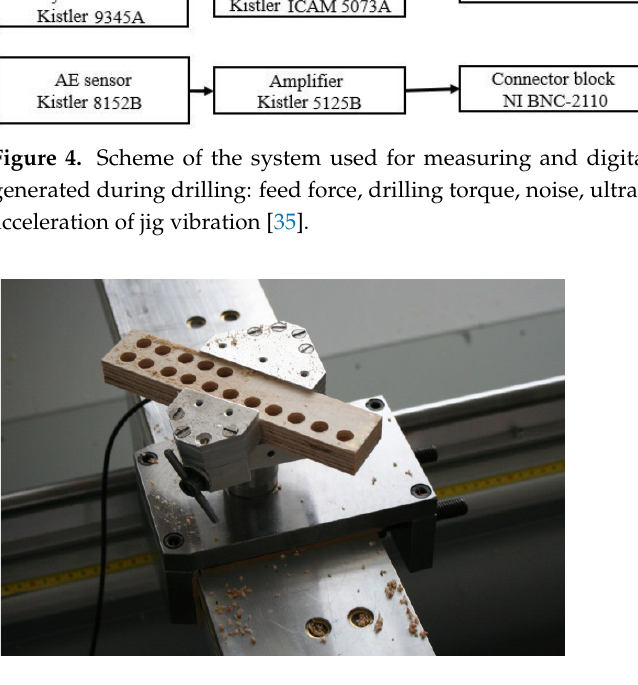
Figure 5. The special force gauge in which the workpieces were